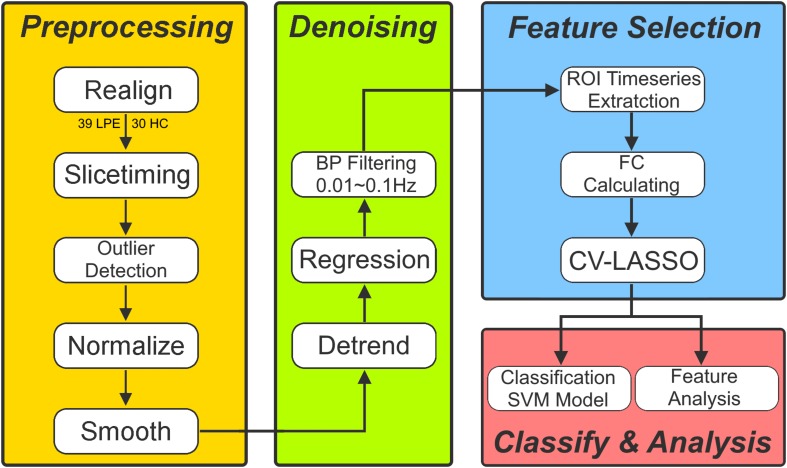
The framework of study procedure.